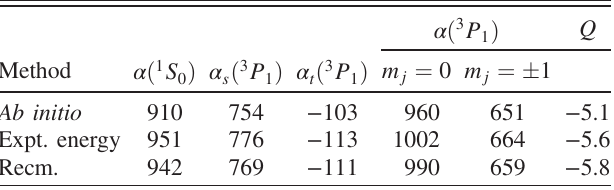
TABLE II. Polarizabilities and Q values of the 5 s 2 1 S 0 and 5 s 5 p 3 P 1 states in a.u. at 515.2 nm for Sr. The recommended Q values (Recm.) are obtained using the polarizability values provided in Table I. The Q values listed in the row labeled “ Expt. energy ” are obtained using the experimental energies and theoretical matrix